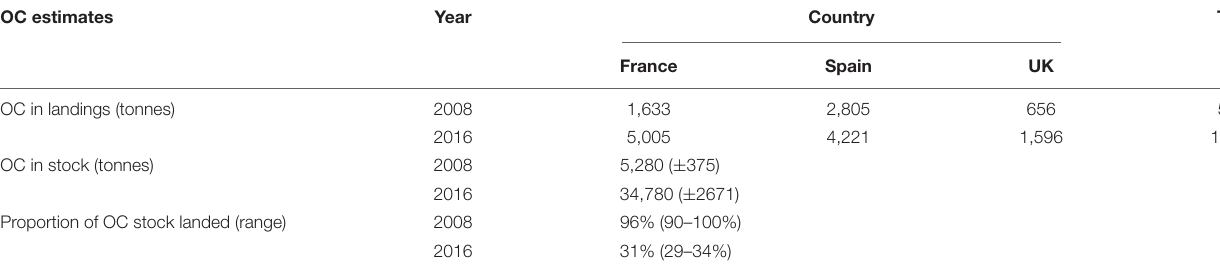
TABLE 3 | Organic carbon (OC) impacts of hake fisheries in France, Spain, and the United Kingdom.